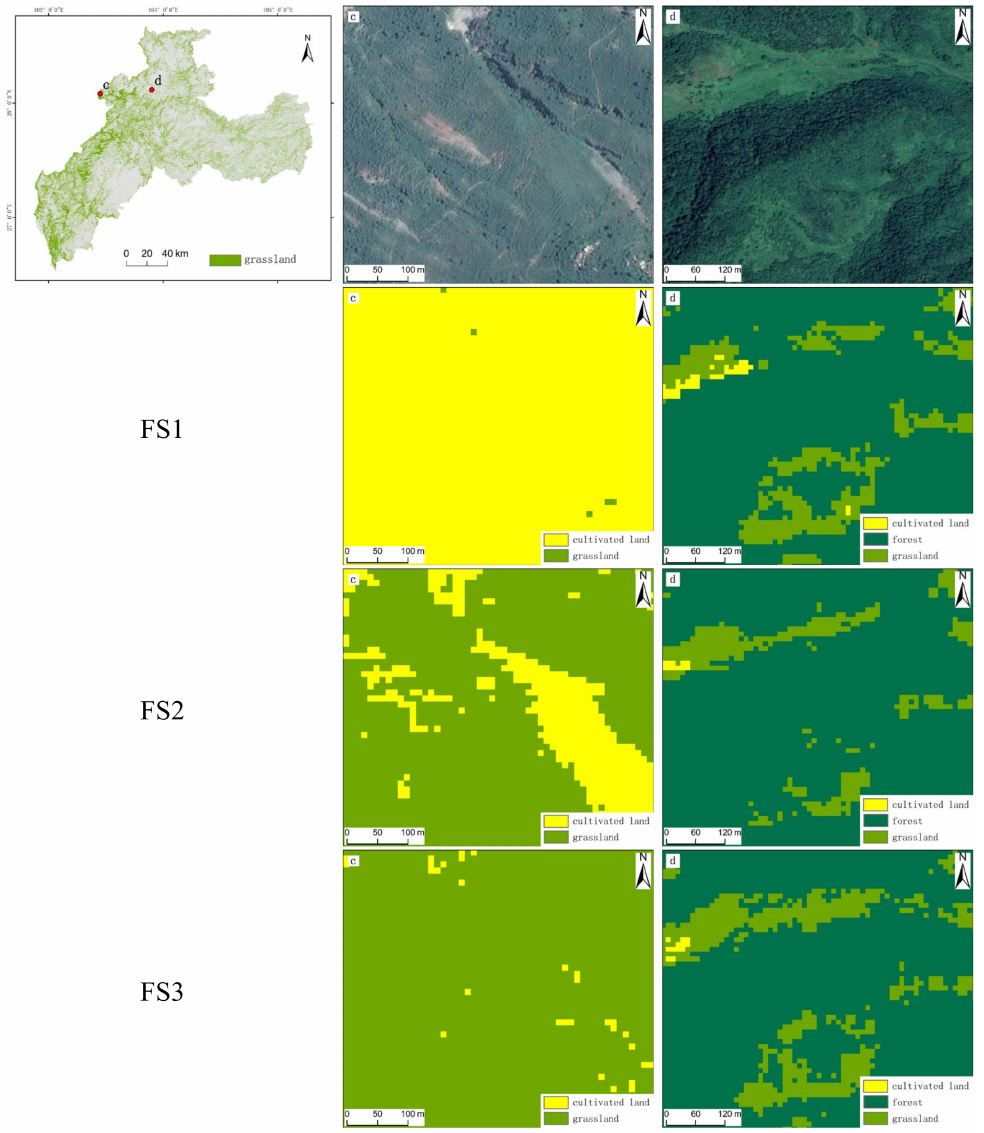
Figure 9. Examples of FS1, FS2, and FS3 classification results. Region c is located on sunny slopes in the low land with steep slopes, and region d is located on shady slopes in the middle land with steep slopes.